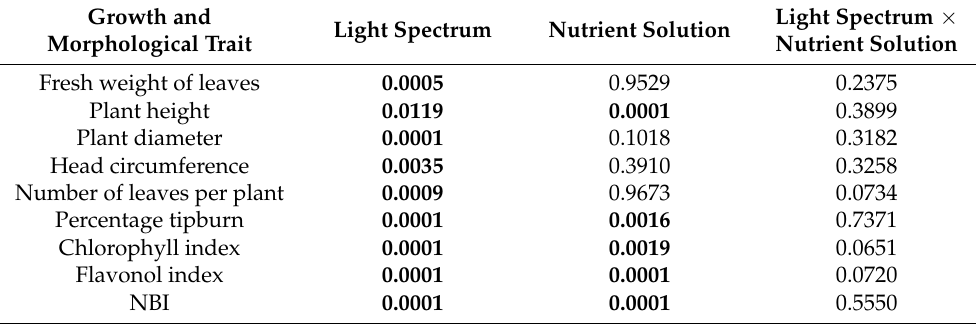
Figure 2. Fresh weight of leaves, plant height, plant diameter, number of leaves per plant, number of tipburn leaves per plant, and head circumference of ‘Elizium’ romaine lettuce grown in a hydroponic system in different nutrient solutions (S and M) under four different light spectra (R:G:B—80:10:10, 70:10:20, 60:10:30, and 70:18:12) in an indoor controlled environment. Bars represent means ± SE. Means followed by the same letter are not significantly different ( p < 0.05) according to Tukey’s HSD test. Table 2. Significance of two-way ANOVA results ( p -values) for the effects of light spectrum and nutrient solution on the measurements of biomass, morphological traits, chlorophyll, flavonol, and nitrogen balance indices (NBI) of ‘Elizium’ romaine lettuce.